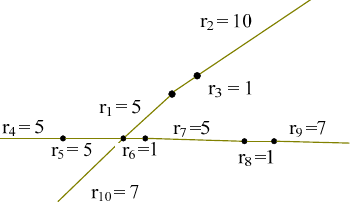
Figure 4. Simplified road network to illustrate of state transition matrix. Table 1. State transition matrix for road network in Figure 4.